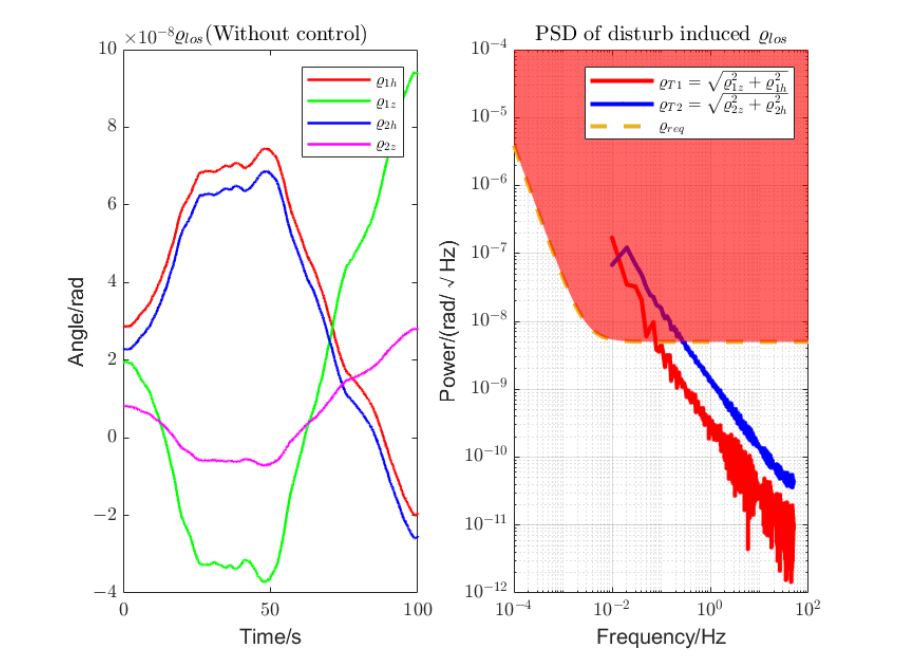
Figure 5. Pointing drift of the telescope. Without any control, the attitude deviation of the LOS pitch and yaw direction drifts under the effect of noise, resulting in the detection performance index not being